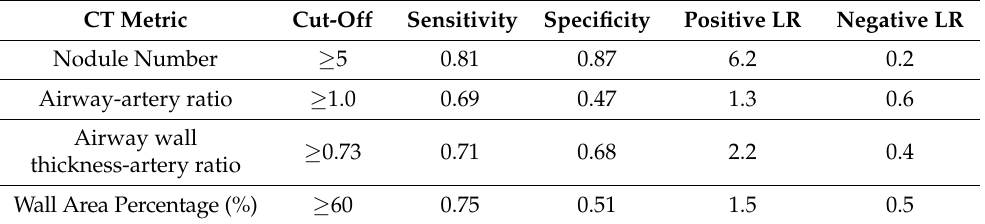
Table 4. Diagnostic performance of quantitative airway and nodule CT features for DIPNECH diagnosis.